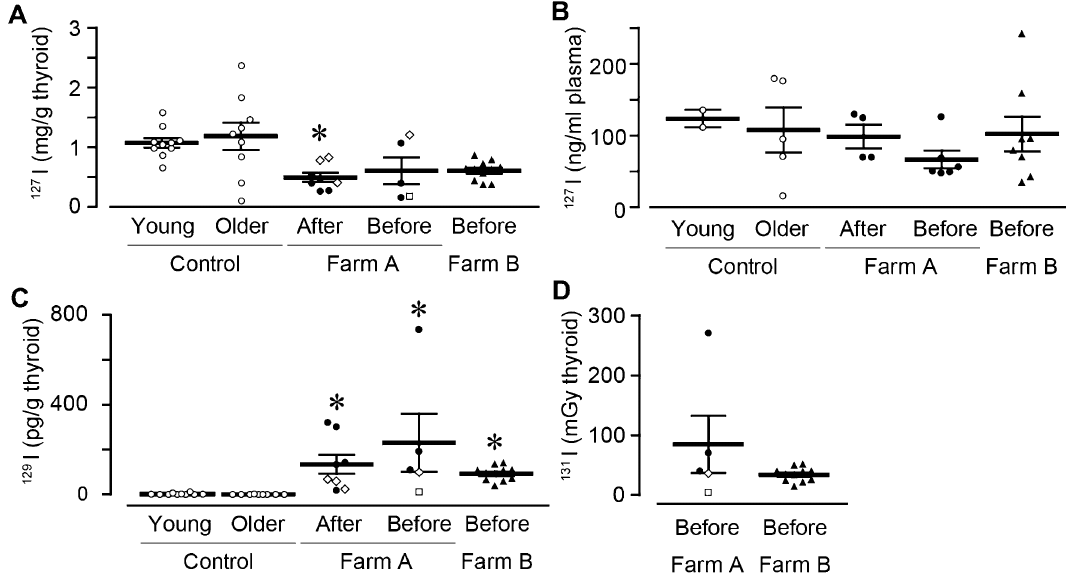
Figure 4. Internal exposure dose by 131 I in cattle thyroid. Thyroids were dissected and the concentrations of 127 I and 129 I were measured. ( A ) The summary of thyroid 127 I (Control, open circle, n = 10 and 9; Farm A, black circle (normal), open square (goiter), and open rhombus (atrophic thyroid), n = 8 and 5; Farm B, black triangle (normal), n = 11). ( B ) The summary of plasma 127 I (Control, open circle, n = 2 and 5; Farm A, black circle (normal), open square (goiter), and open rhombus (atrophic thyroid), n = 4 and 6; Farm B, black triangle (normal), n = 8). ( C ) The summary of thyroid 129 I (Control, open circle, n = 10 and 9; Farm A, black circle (normal), open square (goiter), and open rhombus (atrophic thyroid), n = 8 and 5; Farm B, black triangle (normal), n = 11). ( D ) The summary of estimated thyroid 131 I from the time of the FNPP accident to the euthanasia (Farm A, black circle (normal), open square (goiter), and open rhombus (atrophic thyroid), n = 5; Farm B, black triangle (normal), n = 11). Data are presented as mean ± SEM. *P < 0.05 compared with the control